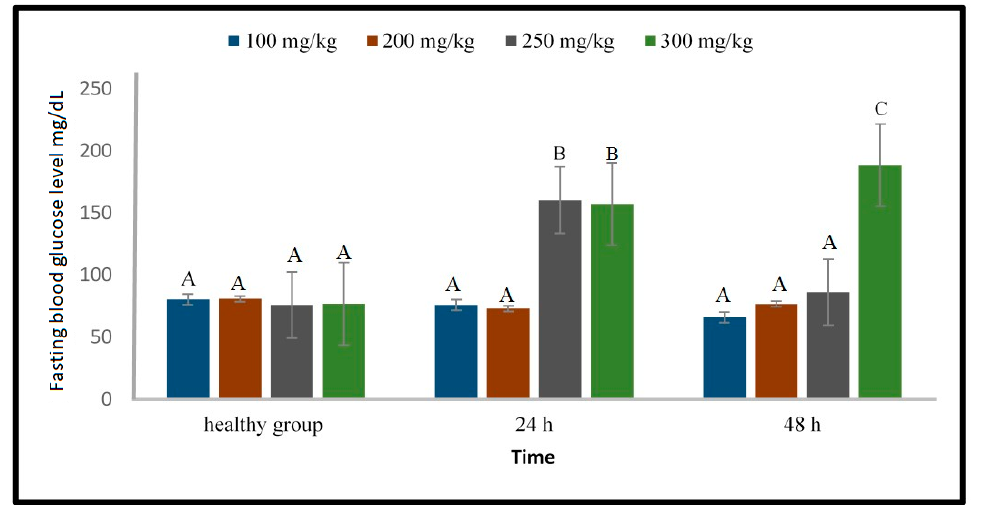
Figure 4. Fasting blood glucose level of zebrafish analyzed after injection of 100, 200, 250 and 300 mg alloxan/kg using 1% sucrose solution. Different capital letter indicates significant difference ( p < 0.05) among the values, n = 10.